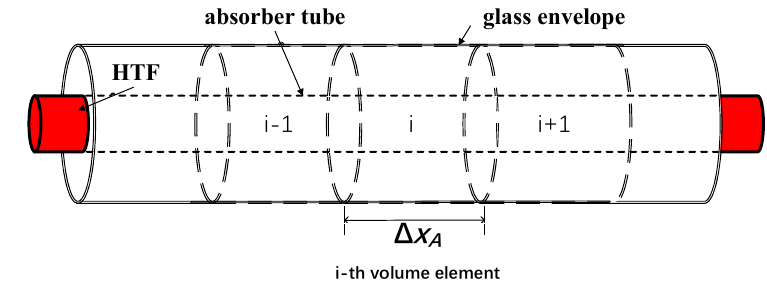
Figure 2. A side view of the solar collector.